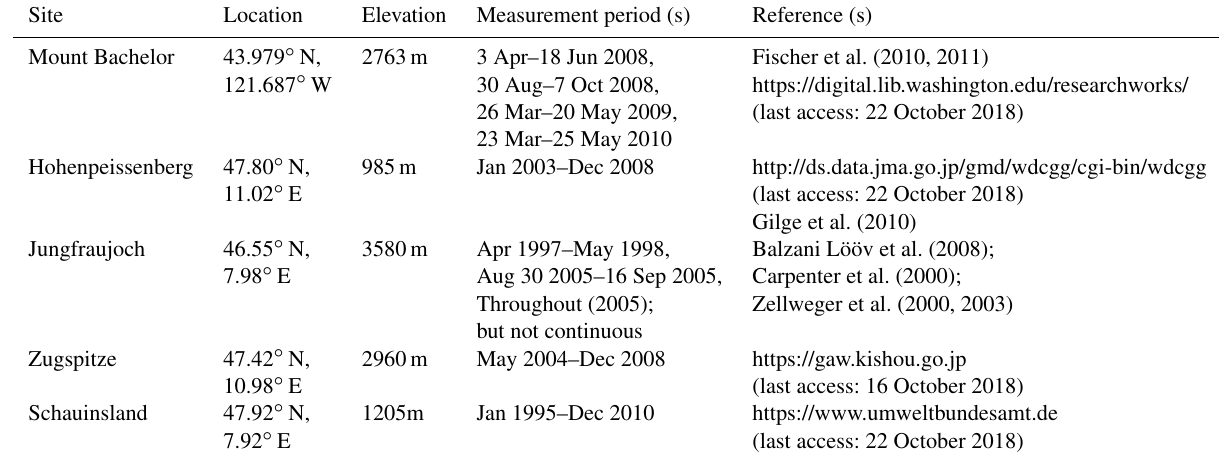
Table 2. Simulations from HTAP1 used in this study. Simulation Description SR1 Base case (see Sect. 2.1 for details). SR6EA SR1 but with anthropogenic emissions of all O 3 precursors (NO x + CO + NMVOC) and aerosols within EA decreased by 20%. SR6EU SR1 but with 20% emissions reductions within the EU region SR6NA SR1 but with 20% emissions reductions within the NA region. COfromEA Idealized tracer simulation in which all models use identical CO emissions, emitted within the EA region, with a 50-day e -folding lifetime. COfromEU Same as COfromEA but for the EU region. COfromNA Same as COfromEA but for the NA region. Table 3. Mountaintop sites with multiple years of PAN observations used in this study. Site Location Elevation Measurement period (s) Reference